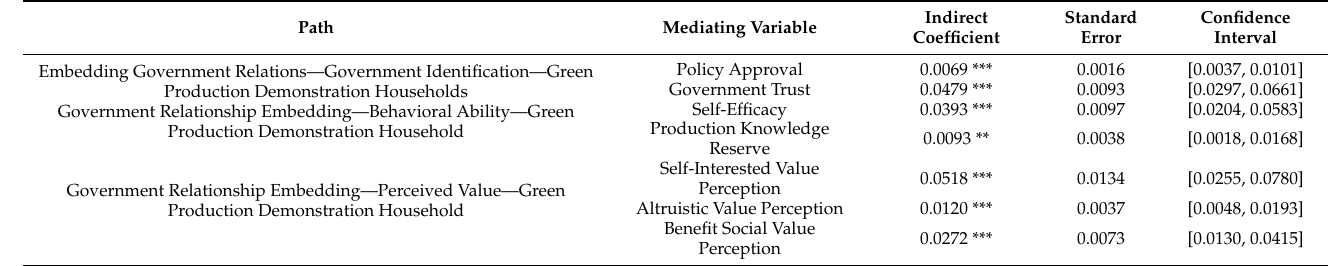
Table 7. Results of Mediation